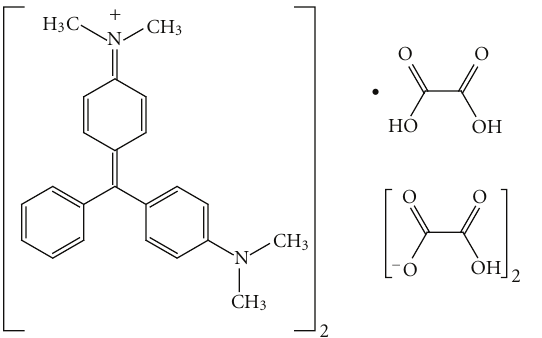
Figure 1: chemical structure of malachite green [19].